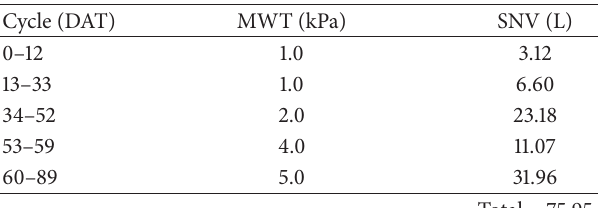
Table 1: Plant cycle in days after transplantation (DAT), maximum water tension in the substratum (MWT), and nutrients solution volume (SNV), as influenced by N concentration in the nutrients